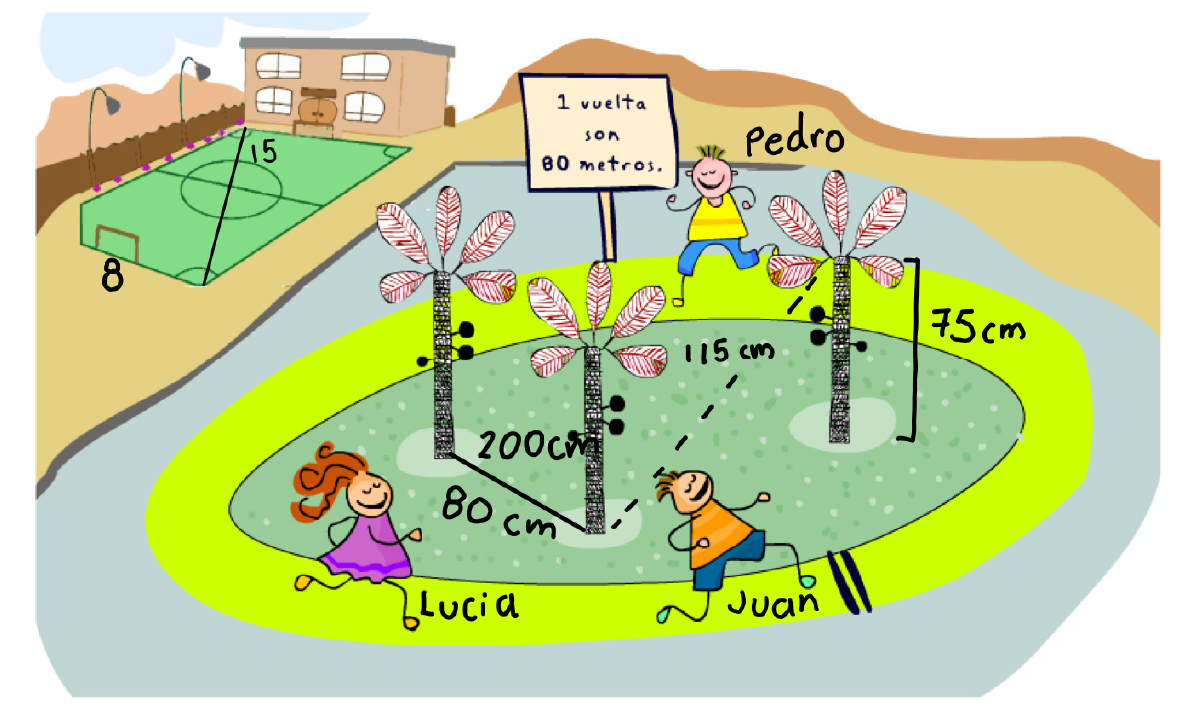
Figure 1. Data added by a